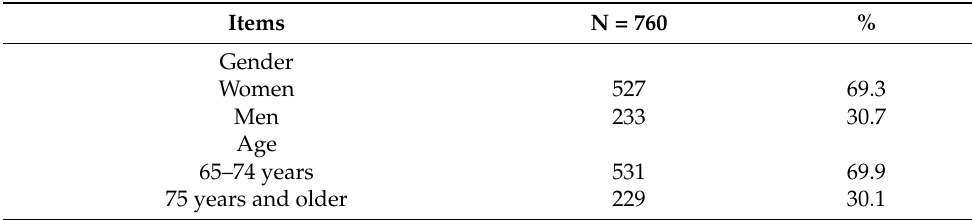
Table 1. Characteristics of the study